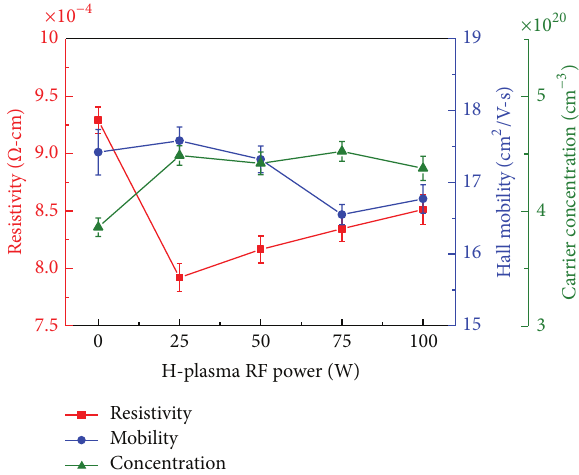
Figure 3: Carrier mobility, carrier concentration, and resistivity of the FZO thin films as a function of H 2 -plasma-treated